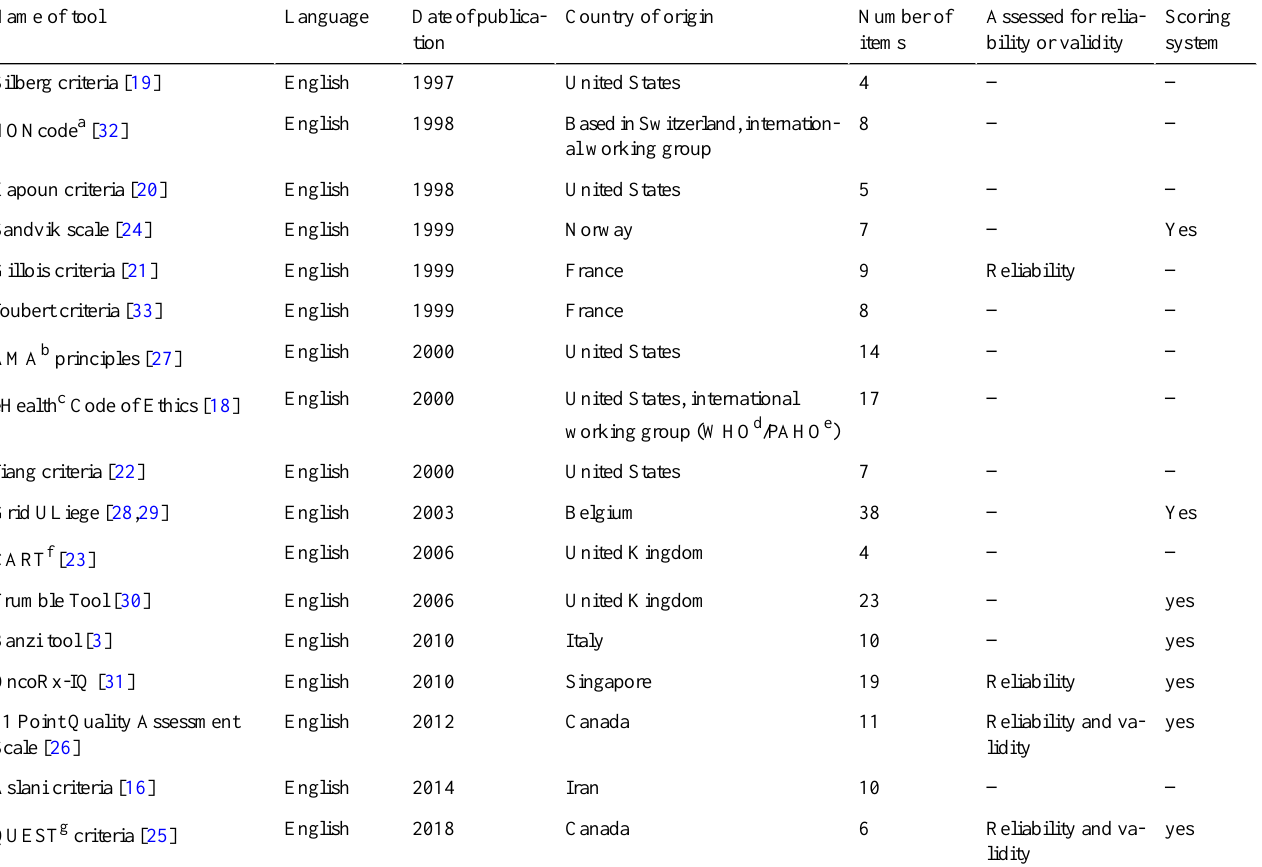
Table 1. Characteristics of the